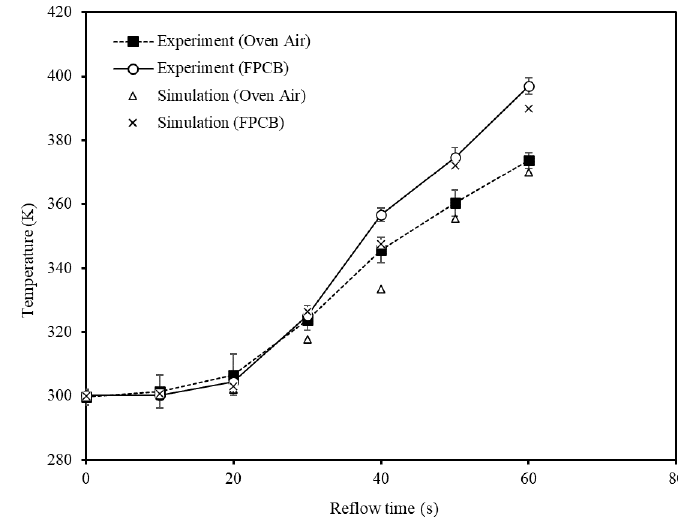
Figure 2. Comparison between experimental and simulation on fluid analysis.